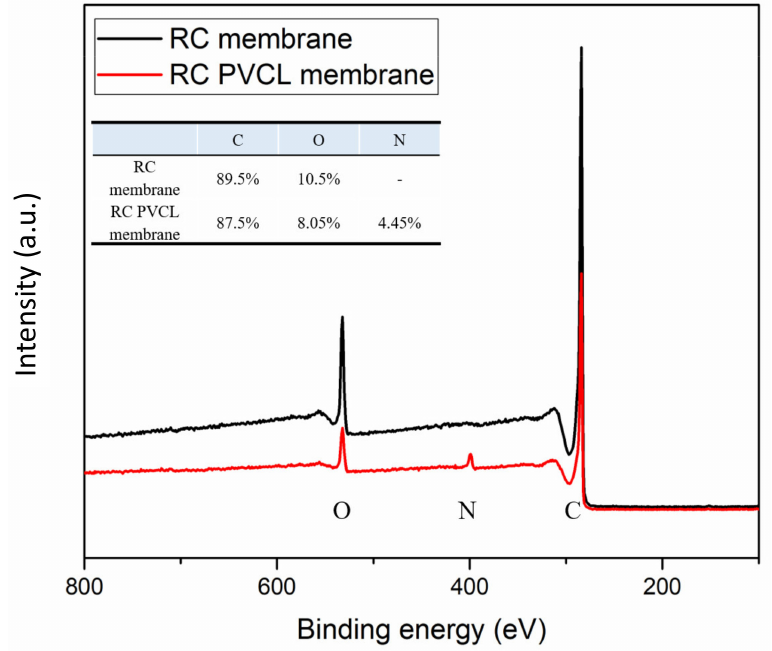
Figure 3. X-ray photoelectron (XPS) spectroscopy of the electrospun RC membranes before and after PVCL ligand